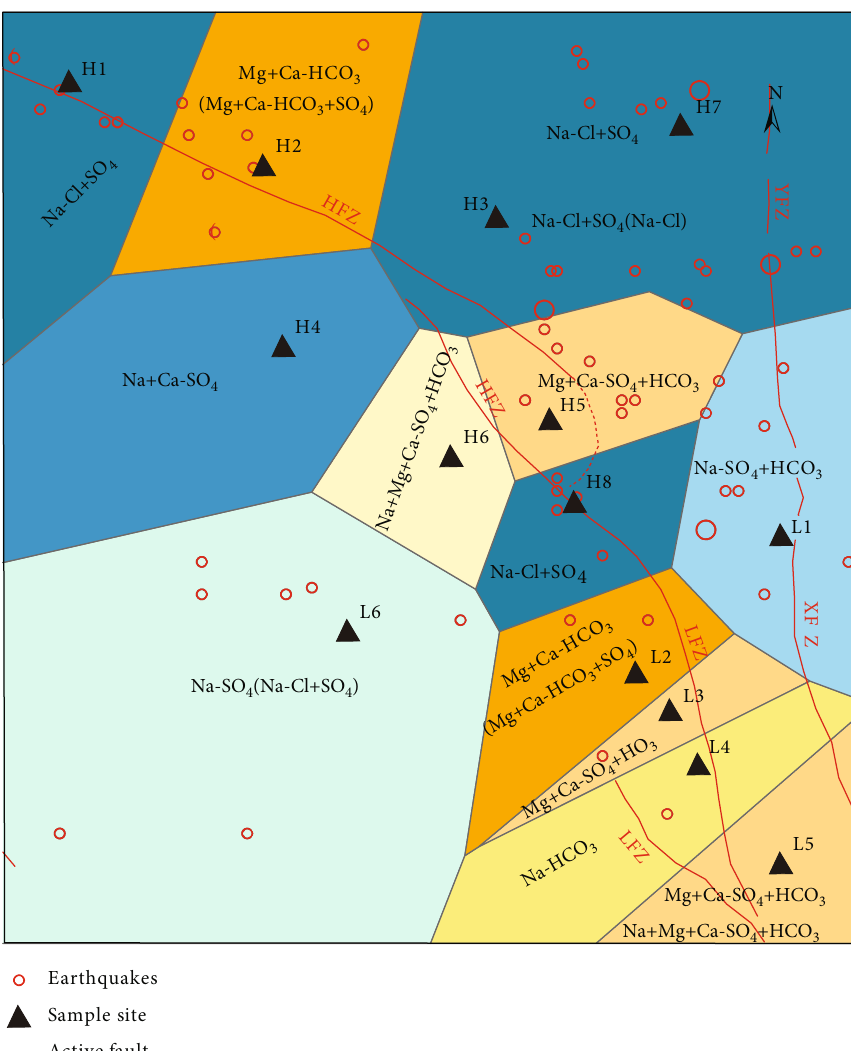
Figure 2: Voronoi diagram of hydrochemical types in HLFZ(Earthquake with M > 3 since 1970 were